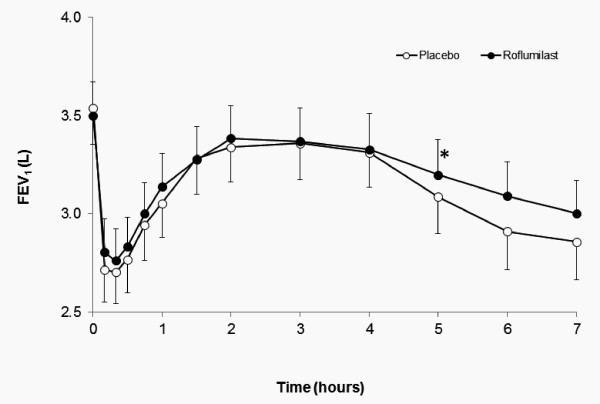
Mean percent fall in FEV1 (± SEM) during the early and late asthmatic responses. Roflumilast significantly inhibited the area of the early and late responses (p < 0.05). FEV1: forced expiratory volume in 1 second.